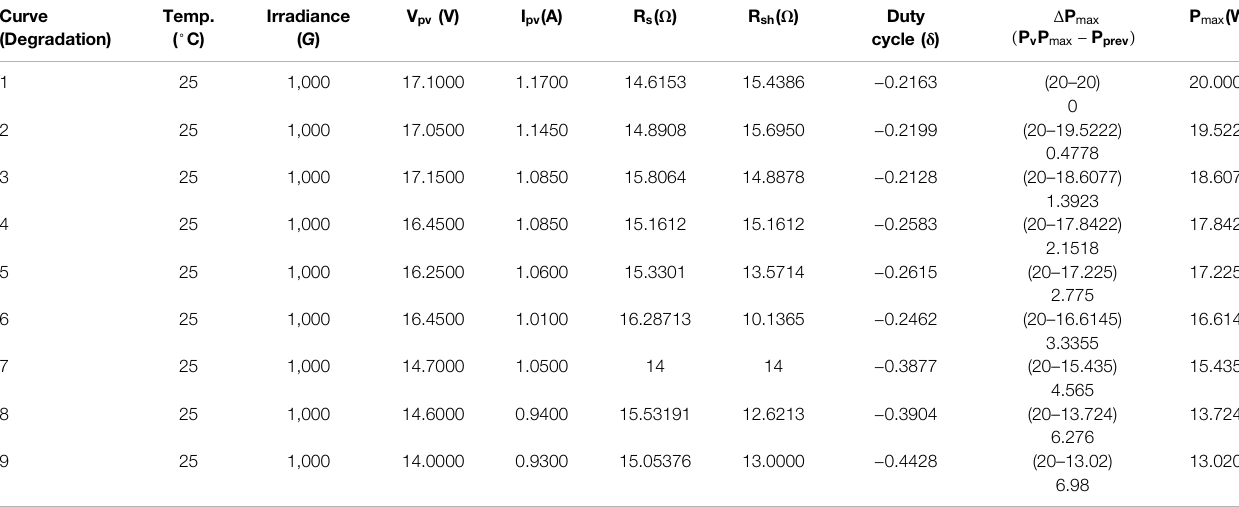
TABLE 1 | A summary of the 2D and 3D optimal output points using the RC-MPPT for multiple curves (degradation).